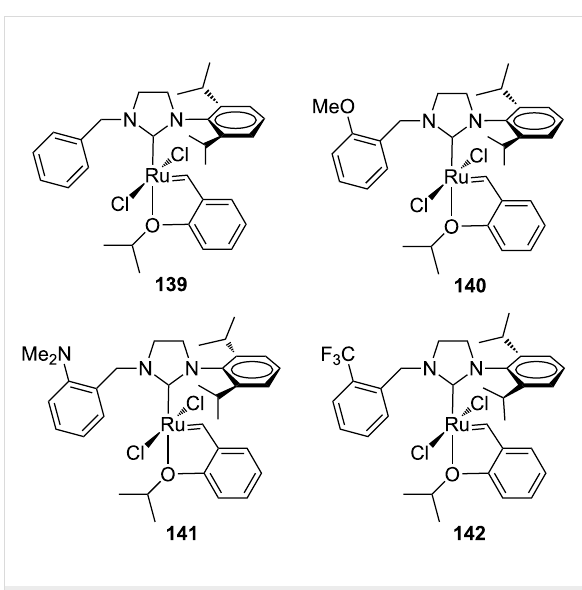
Recently, Grela and co-workers modified the previously re- ported N -benzyl, N’ -aryl NHC–Ru complexes 120 , 121 and 123 , by synthesizing the analogous Hoveyda-type derivatives 136 – 138 (Figure 25). Additionally, the behavior of catalysts 136 – 138 was compared with that of complexes bearing an N -Dipp (Dipp = 2,6-diisopropylphenyl) substituent in place of the N -mesityl group ( 139 – 142 in Figure 26) [46].